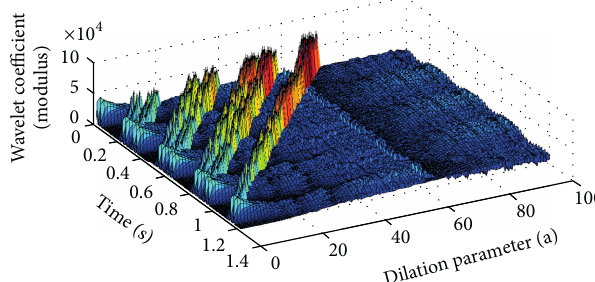
Figure 6: Time-frequency spectrum of the trainload of HSTs (4 carriages) using wavelet